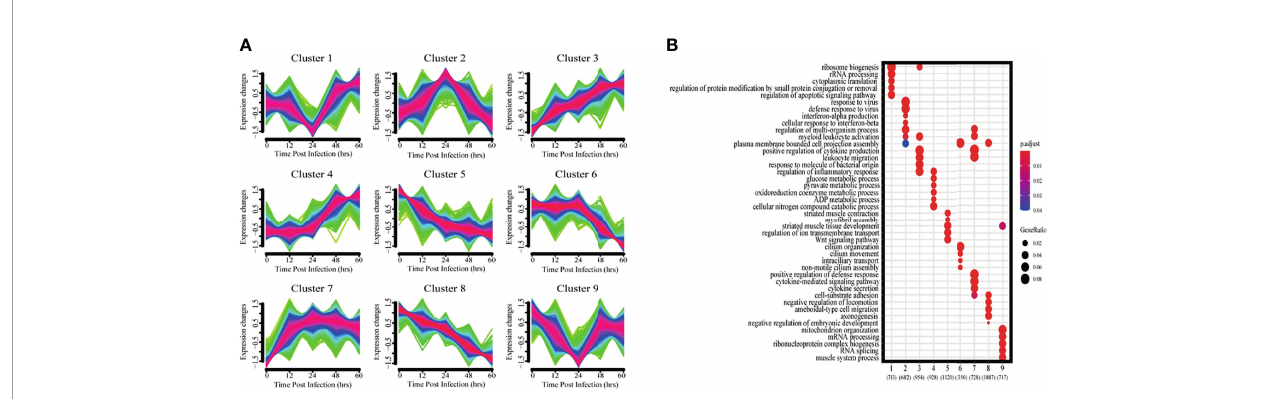
FIGURE 3 | Clusteringanalysis of expression patterns based on DEGs. (A) ClusteringbyMfuzz identi fi ed nine distinct temporal patterns of gene expression.Red indicates the variation of gene ismore conformed to the center of the cluster,followed by blue, and fi nally green. (B) Heatmapshows the signi fi cance of the geneontology (GO)terms inthe biological processes describing each of the nine clusters. The number ofenrichedgenes belonging to each cluster